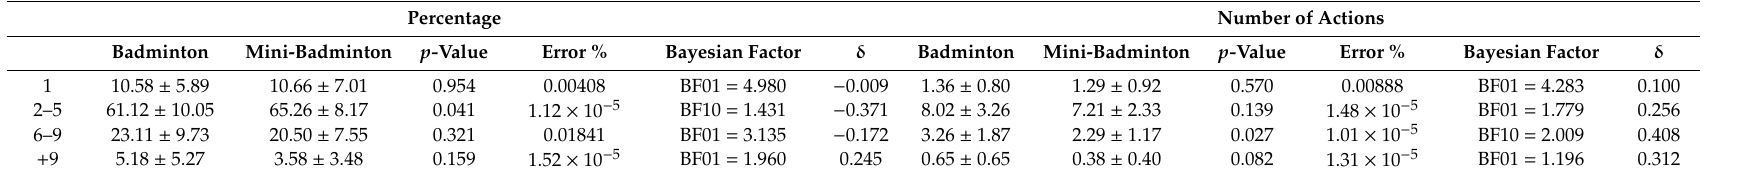
Table 8. Bayesian analysis of usage percentage and stock count technical and tactical according to